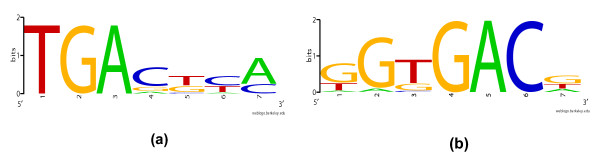
Results on the human c-Jun regulon. (a) The known motif. (b) Motif reported by PhyME, using mouse and rat orthologs.